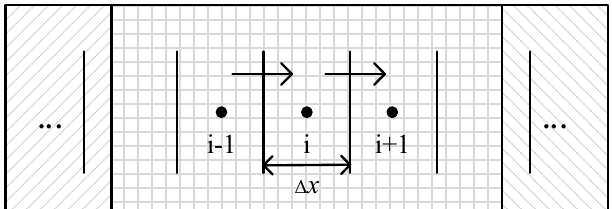
Figure 2. Control volume for heat conduction in